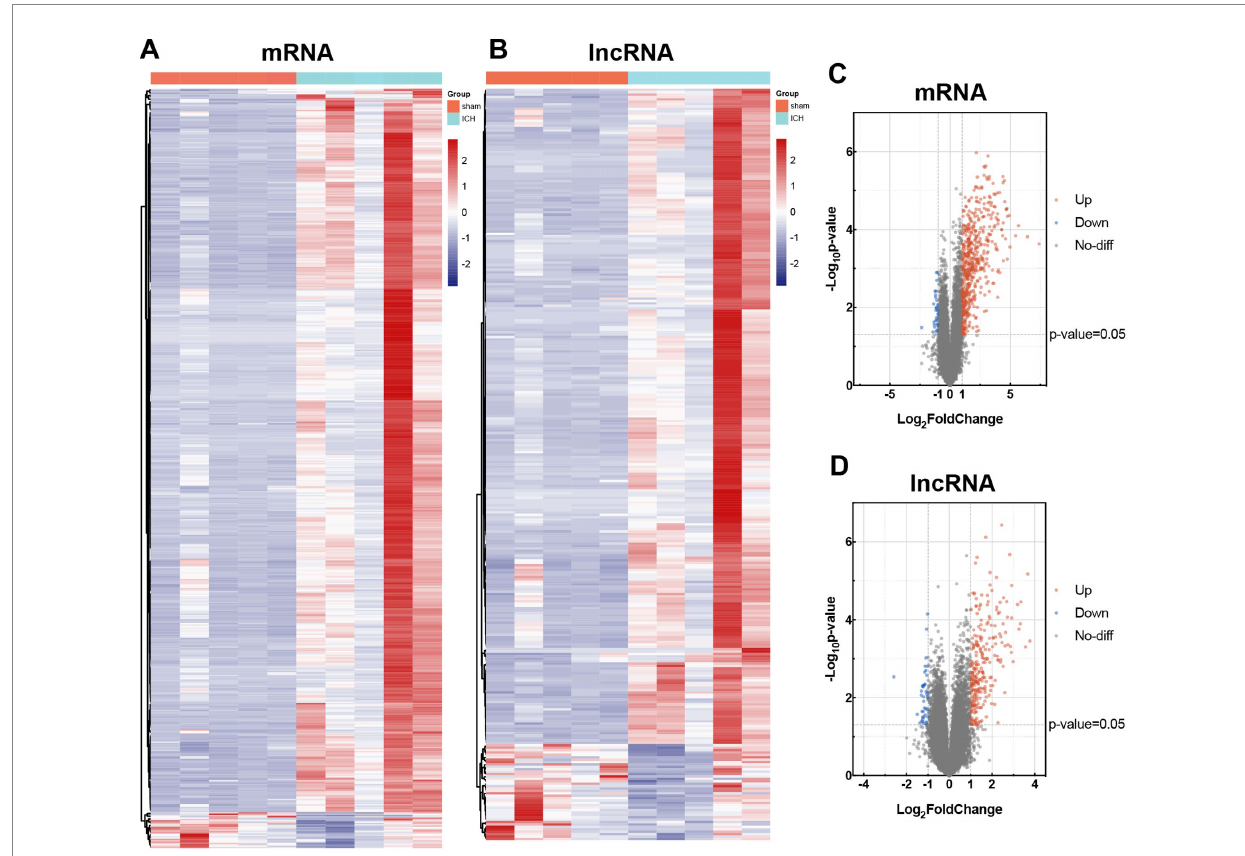
FIGURE 3 Differential expression of mRNAs and lncRNAs in sham and ICH group. Heat maps of differentially expressed mRNAs (A) and lncRNAs (B) . Cluster analysis was carried out with rows. Volcano maps of differentially expressed mRNAs (C) and lncRNAs (D) . Differentially expressed mRNAs and lncRNAs were according to the cutoff of log |FC| ≥ 2 and value of p <0.05. The up-regulated transcripts were marked in red, and the down-regulated transcripts in blue.